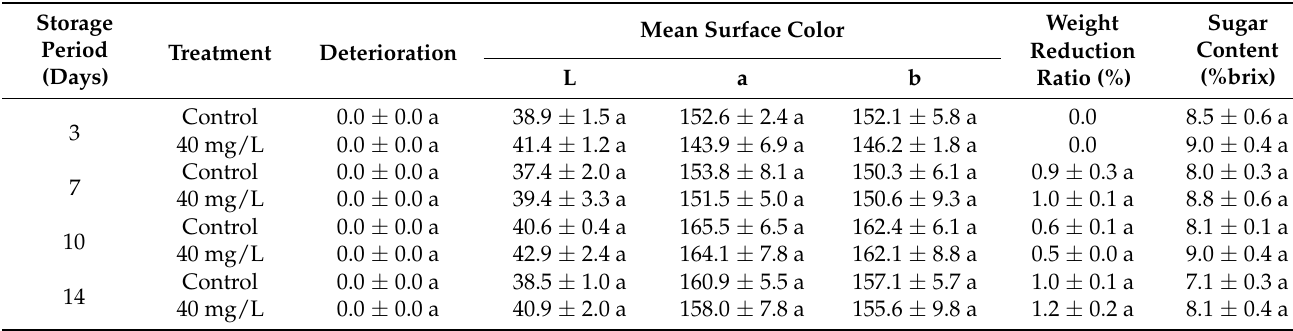
Table 6. Phytotoxicity on strawberry (‘ Maehyang ’ cultivar) exposed to 40 mg/L methyl bromide for 3 h (Ct product = 87.3 mg h/L) at 18 ◦ C in 500 L container, then stored at 5 ± 1 ◦ C.